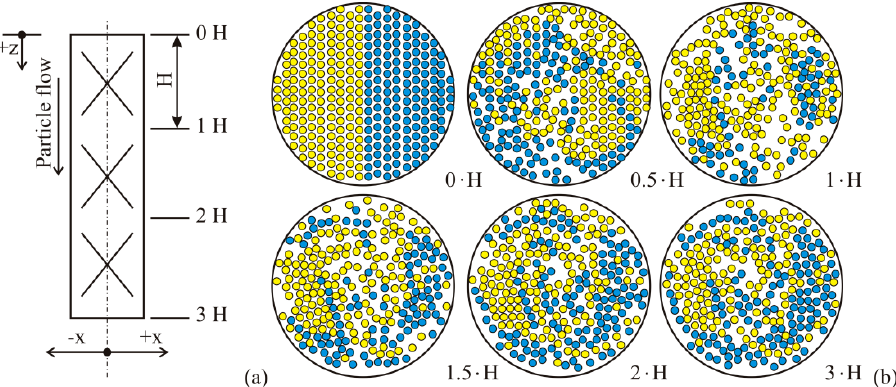
Figure 4. Three-element vertical static mixer scheme. ( a ) Poincare maps of the particle trajectories from different Poincare sections in the three-element vertical static mixer (H—mixing element height) ( b ).